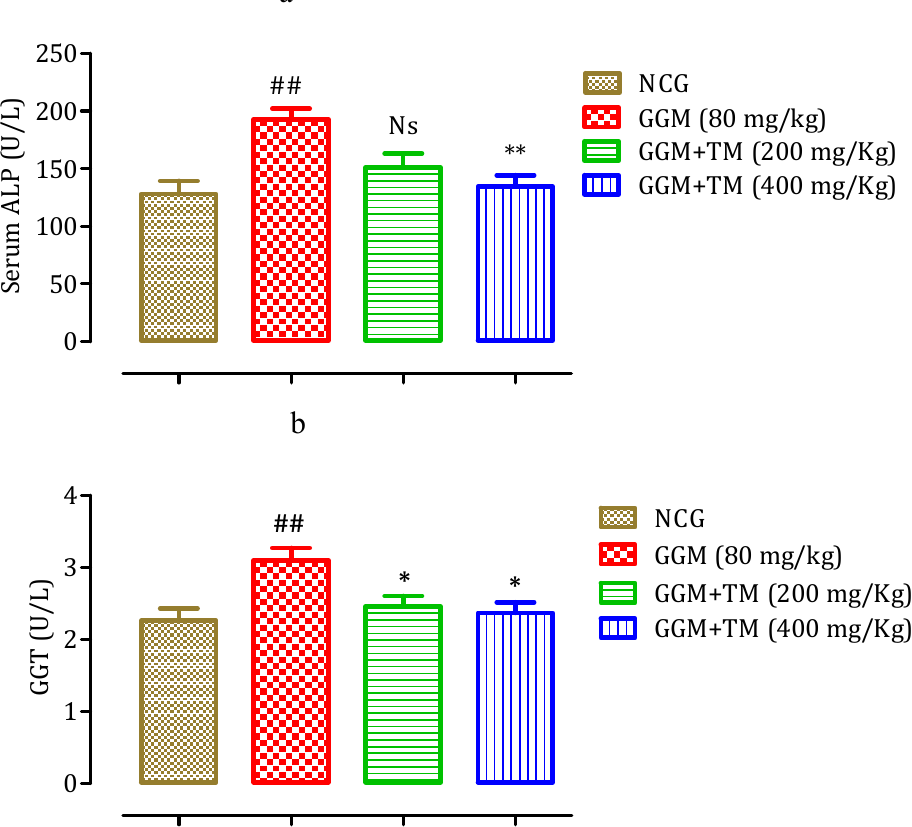
Figure 6. Effect of aqueous APTM extract on serum gamma-GT ( b ) and ALP ( a ) concentrations in GM-poisoned rats. ## p < 0.01 related to NCG. * p < 0.05, ** p < 0.01 compared to GGM. Ns: not significant compared to GGM.